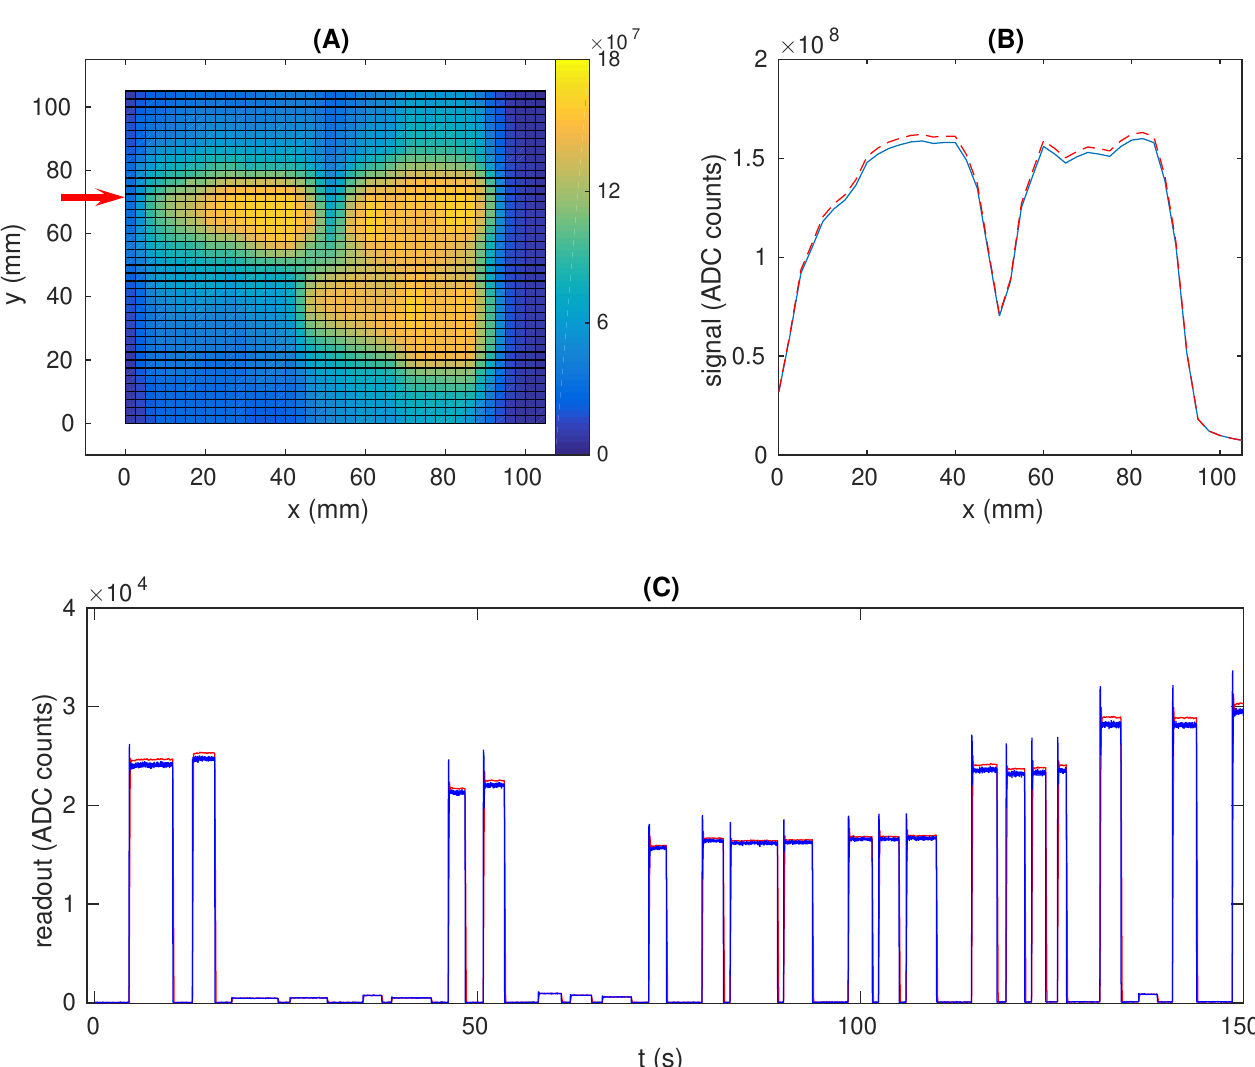
Figure 2. Effect of recombination and recombination correction in the verification of a dynamic radiotherapy clinical treatment with a liquid-filled ionization chamber array of 43 × 43 pixels of 2.5 mm × 2.5 mm each. ( A ) Raw acquisition with a LINAC monitor unit rate of 600 MU/min. ( B ) Representative profiles (along the line highlighted in panel ( A ) with a red arrow) of the raw (solid line) and corrected (dashed line) acquisitions. ( C ) Profile of the raw readout current in a pixel of the detector (blue line) and the corrected readout (red